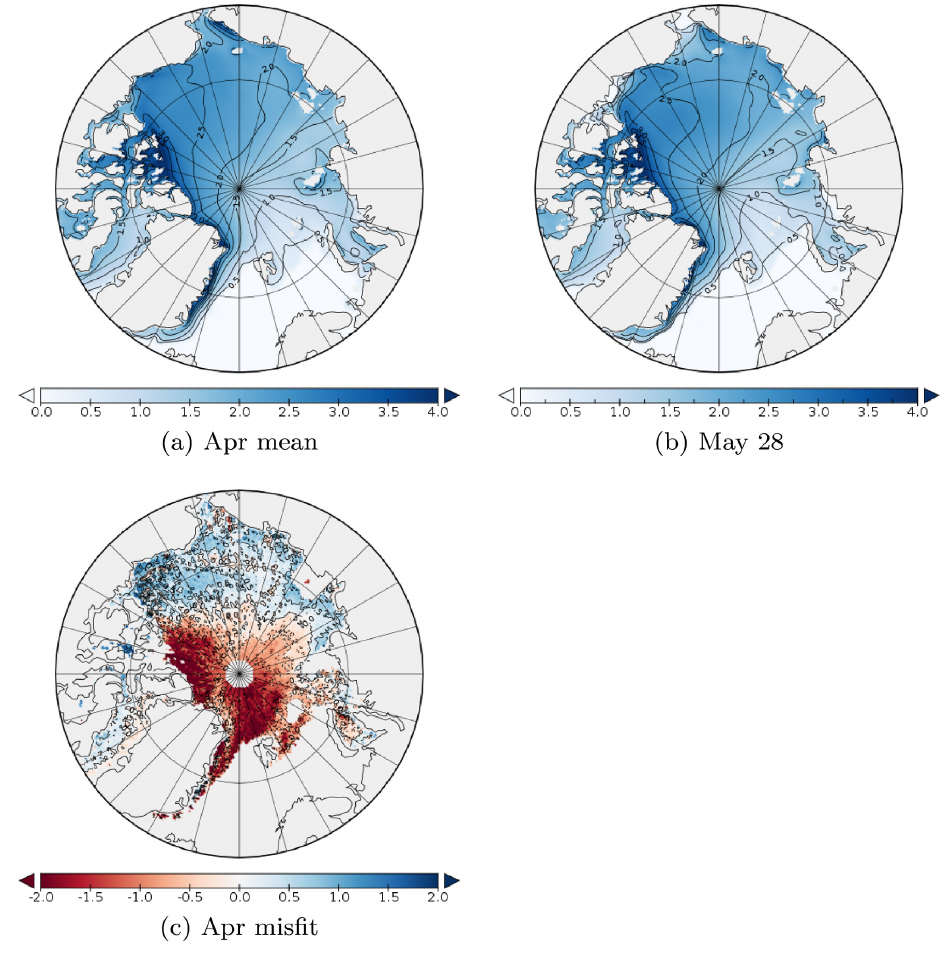
Figure 8. (a) The modelled mean April 2015 sea ice thickness (m), (b) the modelled sea ice thickness on 28 May 2015, and (c) the mean April 2015 misfit of the modelled sea ice thickness relative to the CryoSat-2 sea ice thickness. In panel (c) , shades of red indicate underesti- mation and shades of blue indicate overestimation of sea ice thickness in the